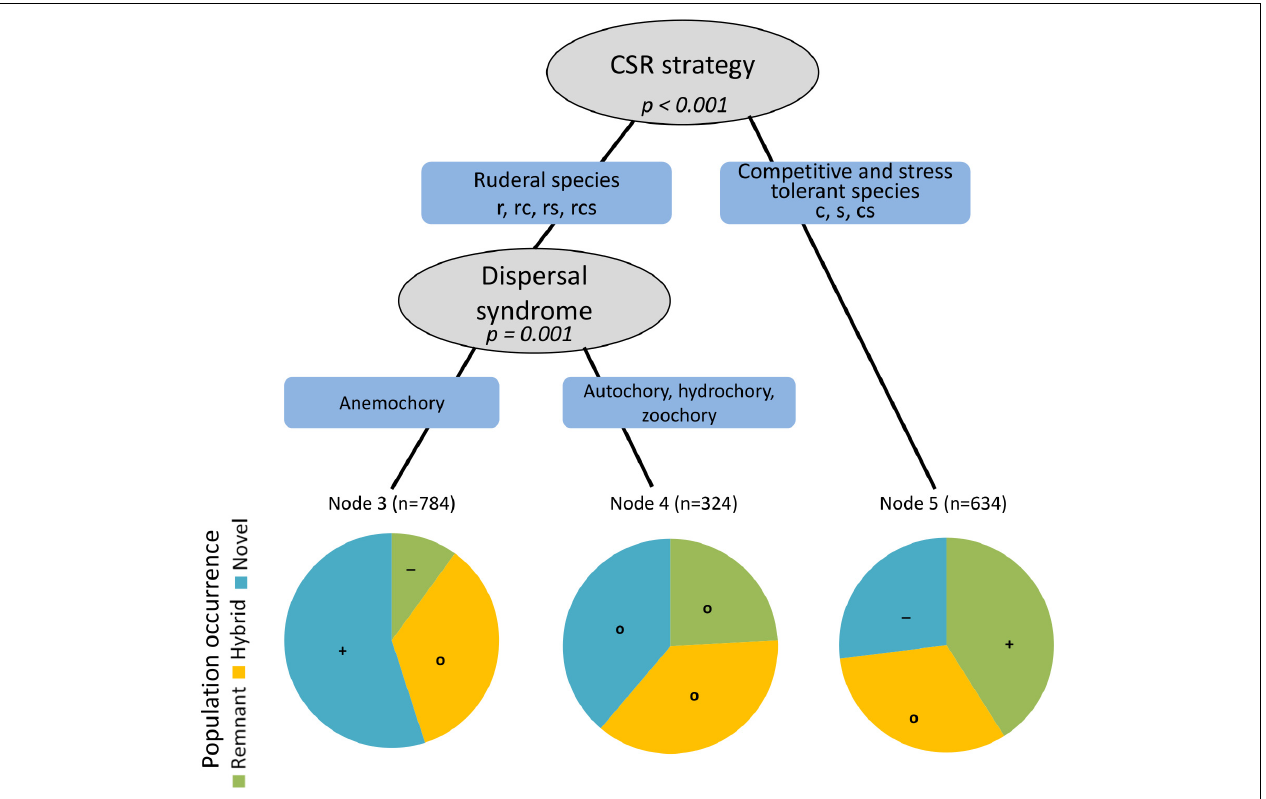
FIGURE 4 | Conditional inference tree showing the partitioning effects of plant dispersal syndrome and CSR strategy on the occurrence of populations of endangered plant species across natural remnant (green), hybrid (yellow) and novel (blue) ecosystems in Berlin. Positive and negative deviations from the expected frequencies of population from the three novelty types are displayed by symbols in the pie charts (+, more than four standardized residuals showing an overrepresentation of populations of the respective category; –, less than four standardized residuals showing an underrepresentation of populations; o, –2 to 2 standardized residuals, showing a similar representation of populations to the expected frequencies); n indicates the number of populations in each